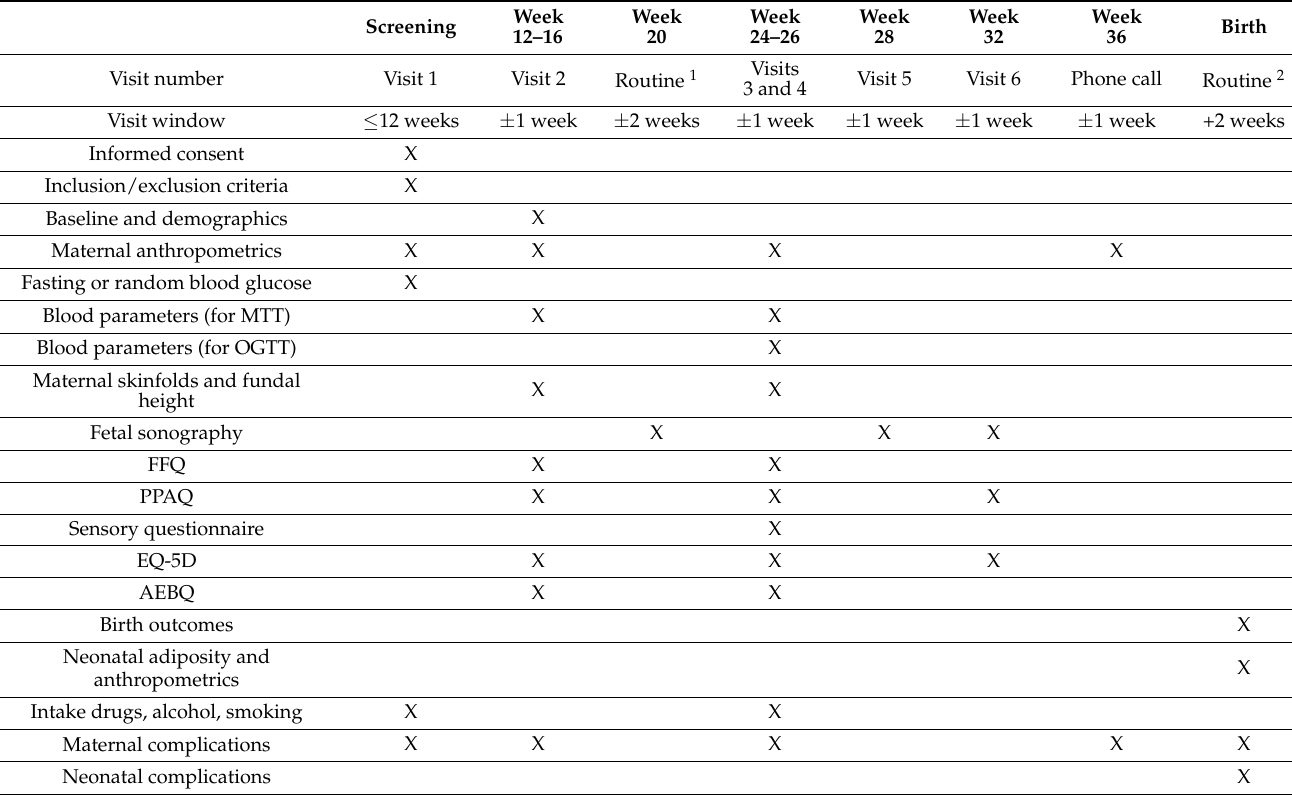
Table 1. Timing of data collection during pregnancy up to 2 weeks postpartum in mother and fetus-infant.